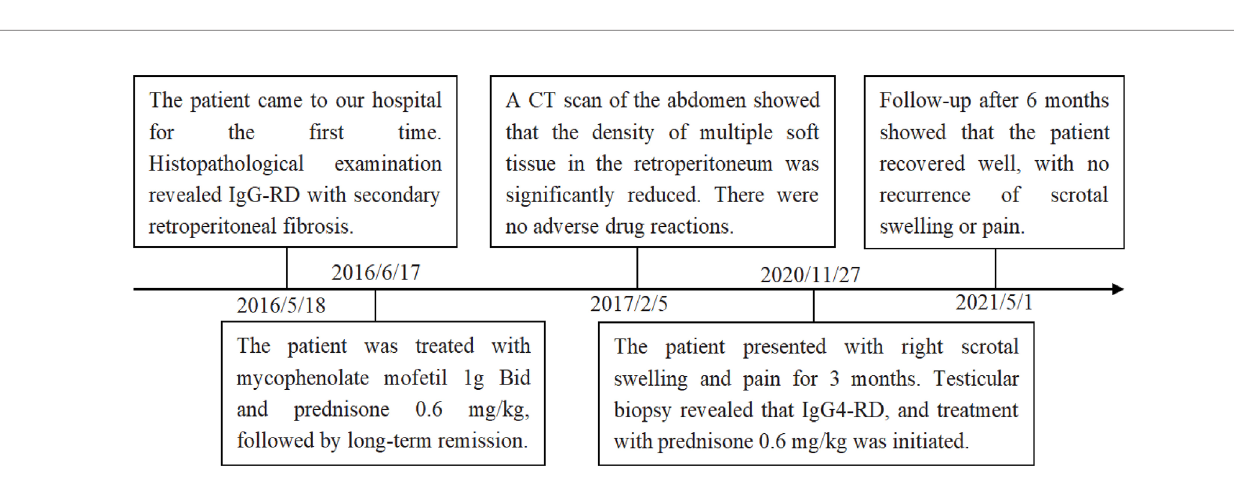
FIGURE 3 | Timeline of diagnosis, treatment, and prognosis in this